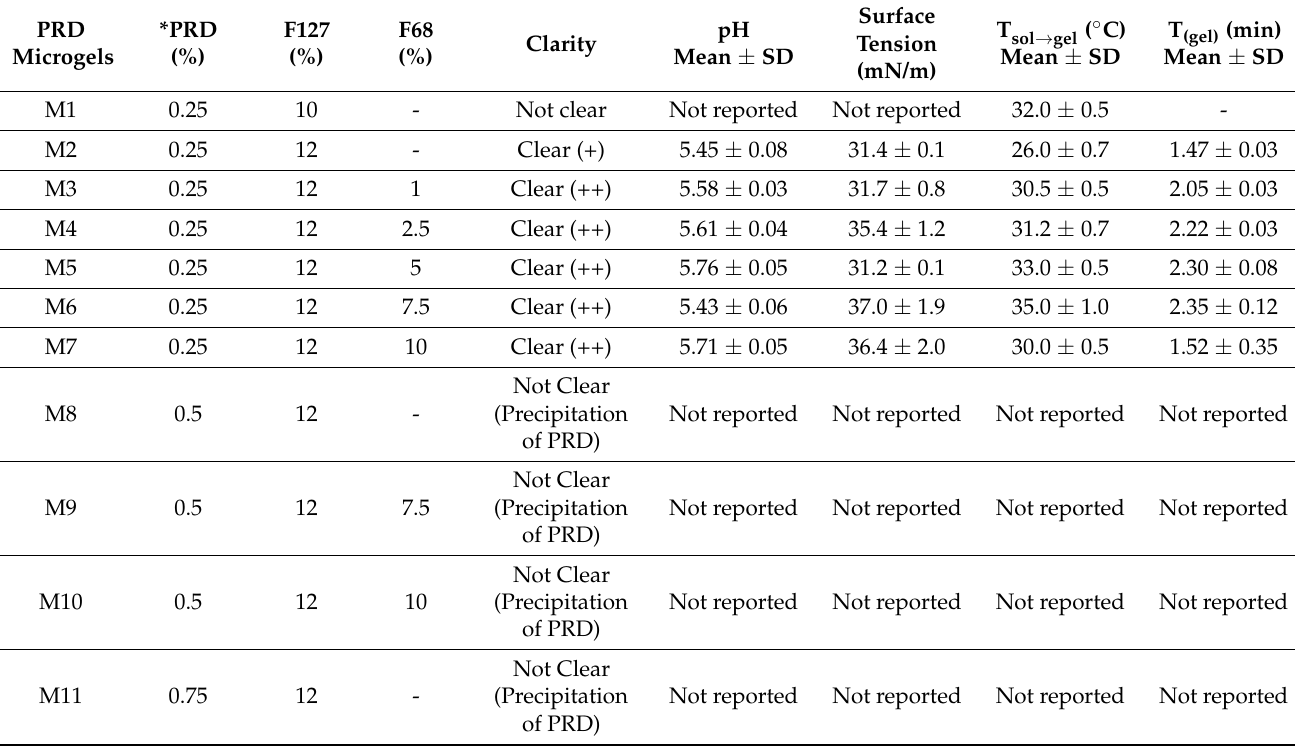
Table 3. Composition and Tsol → gel of PRD